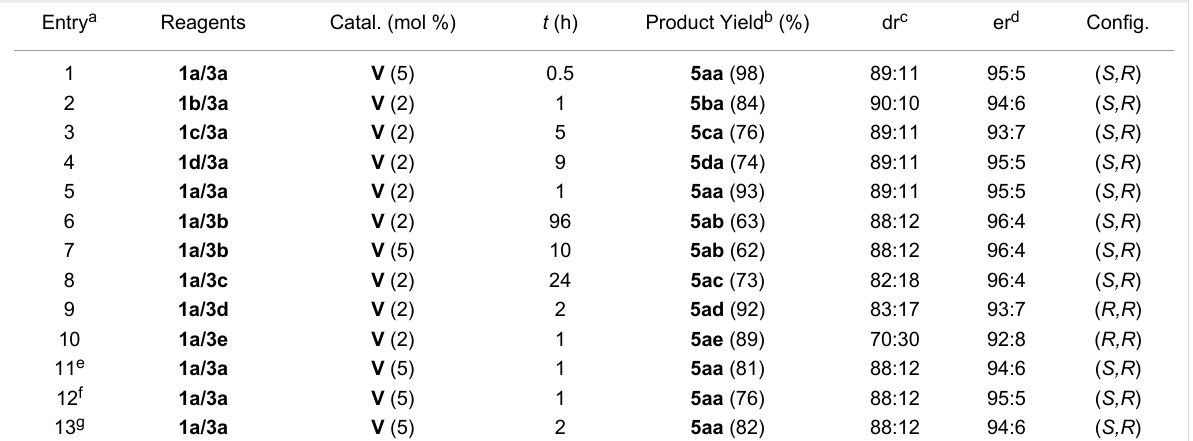
Table 3: Reaction of nitrostyrenes with β -substituted cycloalkanones catalyzed by V